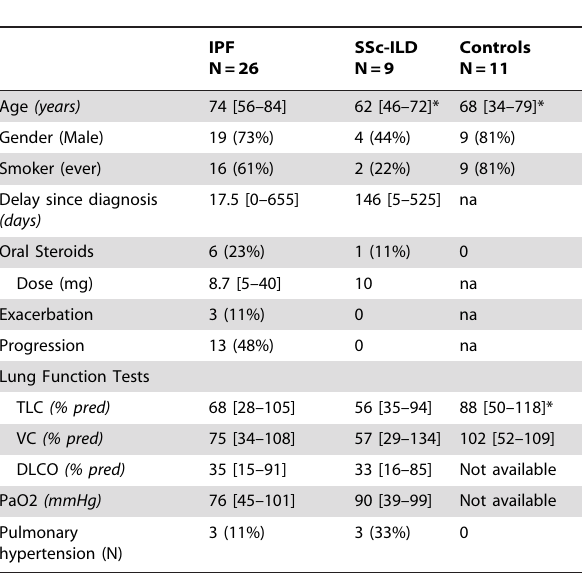
Table 1. Clinical and functional characteristics of the patients.